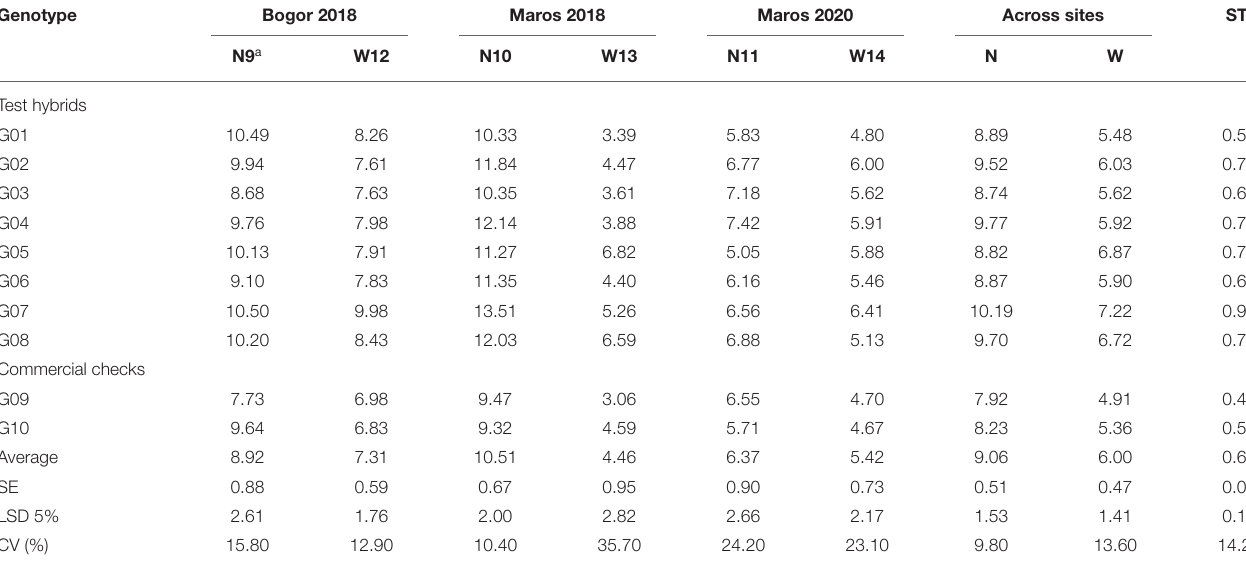
TABLE 5 | Hybrid performance and stress tolerance index (STI) on yield (t ha − 1 ) for each genotype evaluated under normal (N) and waterlogging (W) conditions in Bogor and Maros, 2018 and